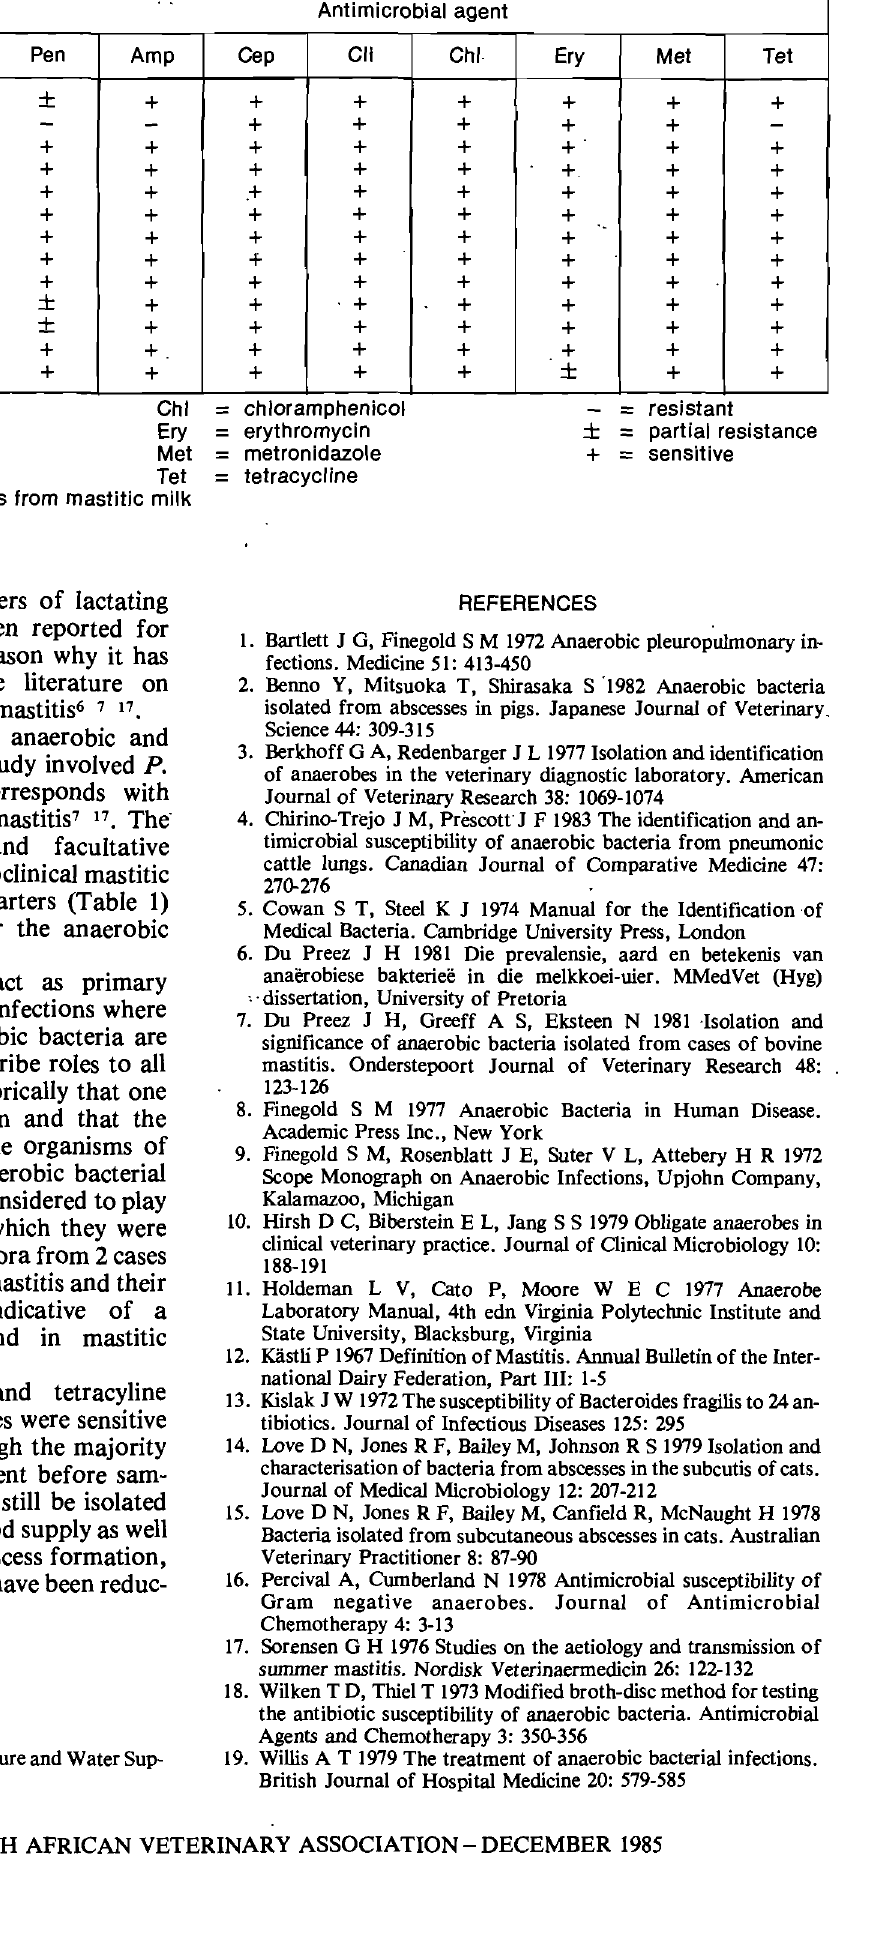
I , , Antimicrobial agent Cep Cli Chi Ery